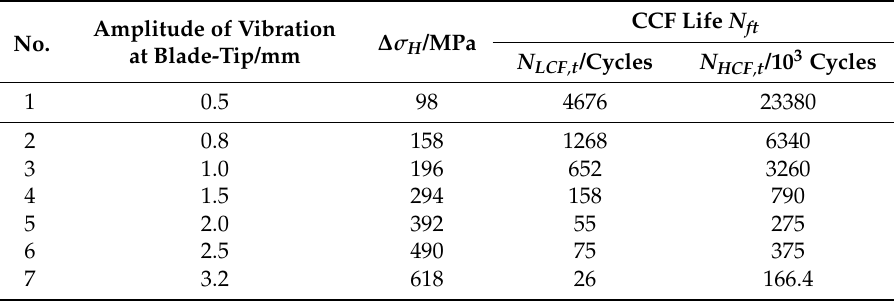
Table 1. CCF test data of turbine blades under different stress